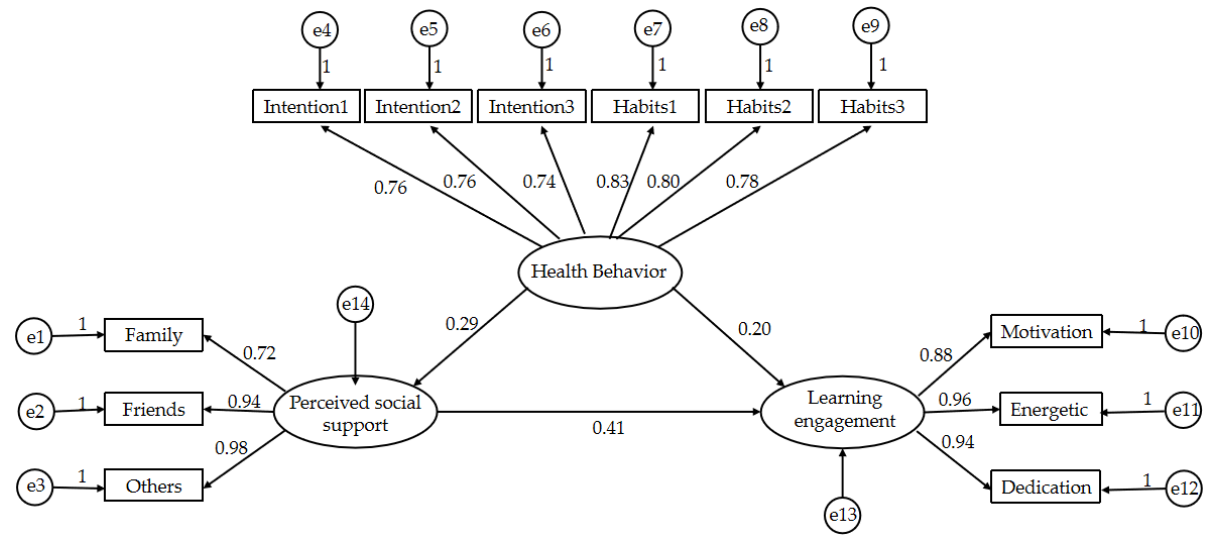
Figure 3. Model of the relationship between health behavior, comprehending social support and learning engagement. Note: e1–e14 are residual